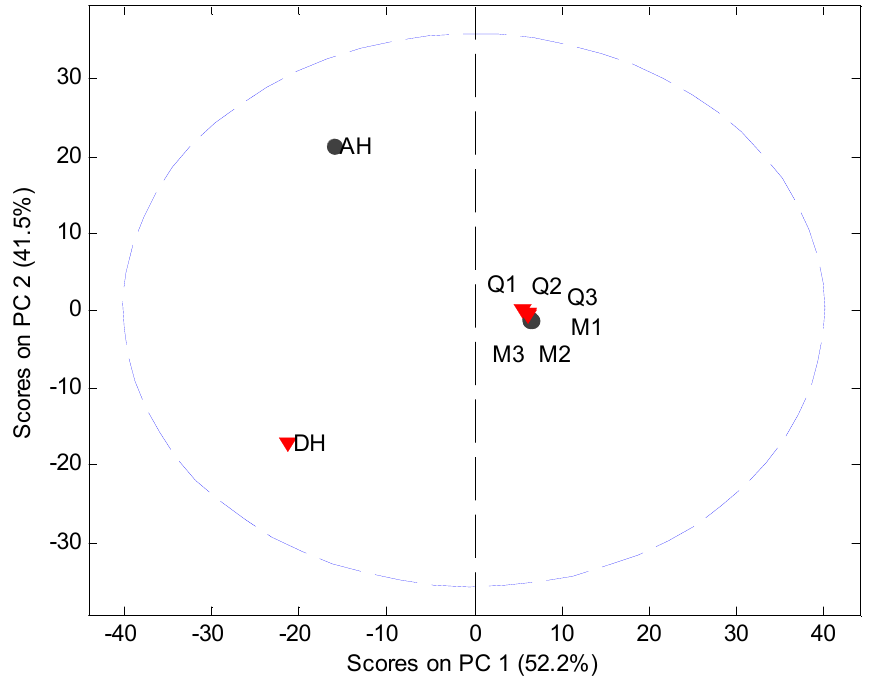
Figure 2. PCA score plot of the original XRPD data (5° 2 θ to 40° 2 θ ) of milled samples (M1, M2 and M3), quench cooled samples (Q1, Q2 and Q3), crystalline anhydrate (AH) and crystalline dihydrate